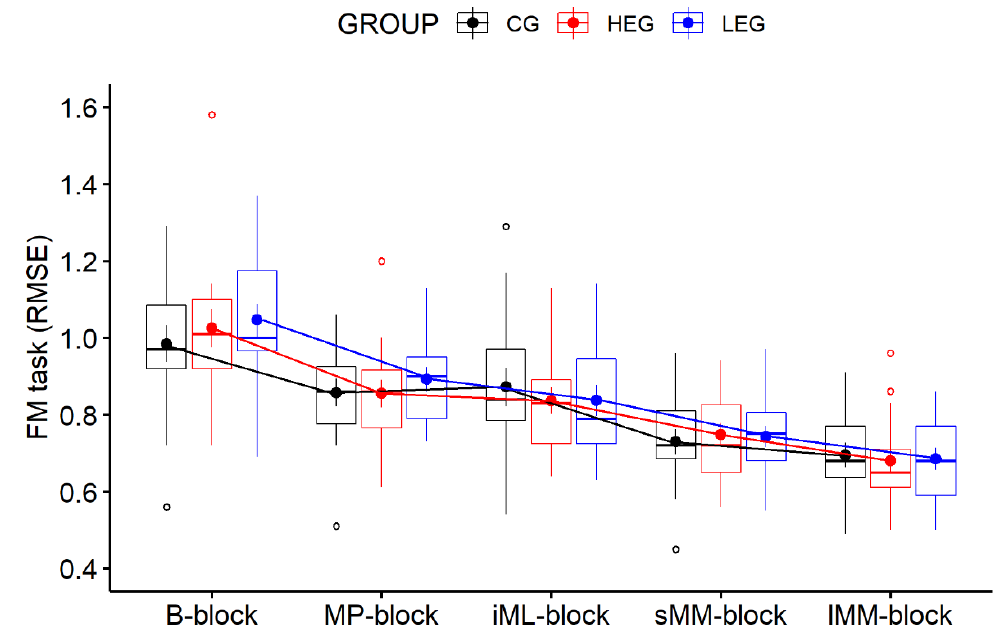
Figure 3. Development of FM task performance over the duration of the experiment ( B-block: baseline; MP-block: motor performance; iML-block: initial motor learning; sMM-block: short-term motor memory; lMM-block: long-term motor memory), as indicated by boxplots containing RMSE means and (±) SEM per group (HEG, LEG, and CG). Outliers were marked as values below the first quartile (–1.5 × IQR) or above the third quartile (+1.5 × IQR) (see Supplementary Table S1 for mean values and SD of RMSE).